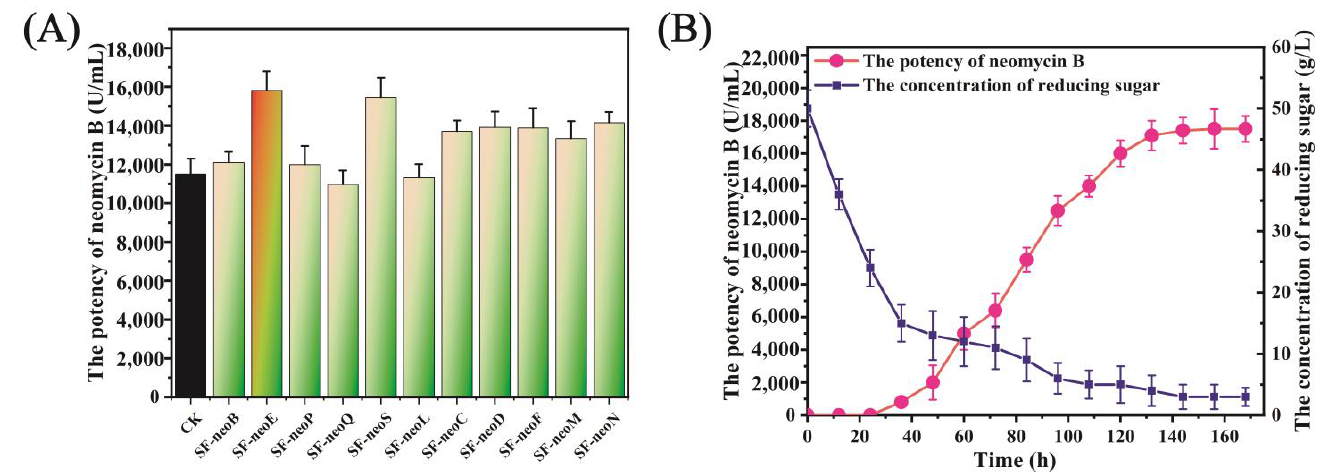
Figure 5. ( A ) The effects of overexpression of single genes of the neo gene clusters on neomycin B biosynthesis in S. fradiae SF-2. ( B ) The effect of 60 mM (NH 4 ) 2 SO 4 on reducing sugar utilization and neomycin B biosynthesis in the SF- neoE strain.